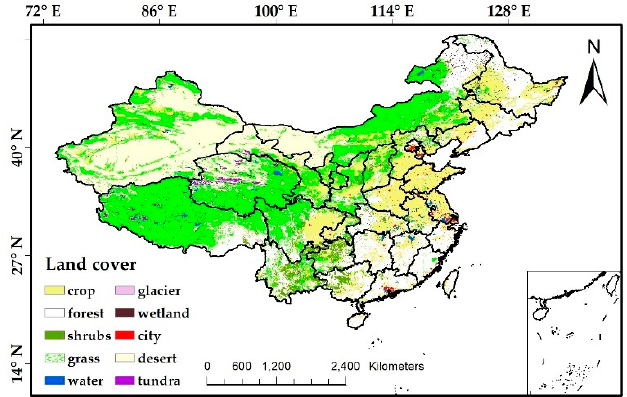
Figure 1. Distribution of land cover in China in 2010.